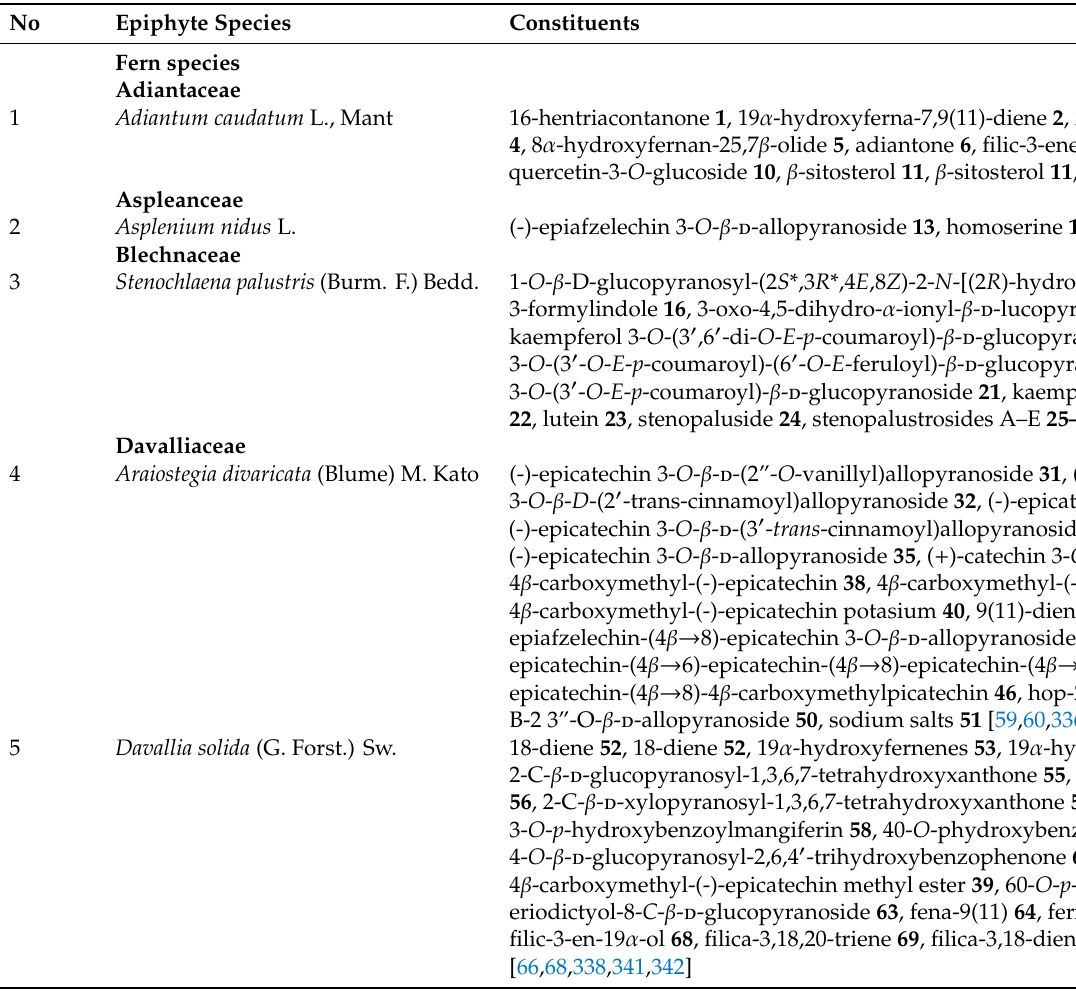
Table 2. Phyctochemical constituents of epiphytic medicinal